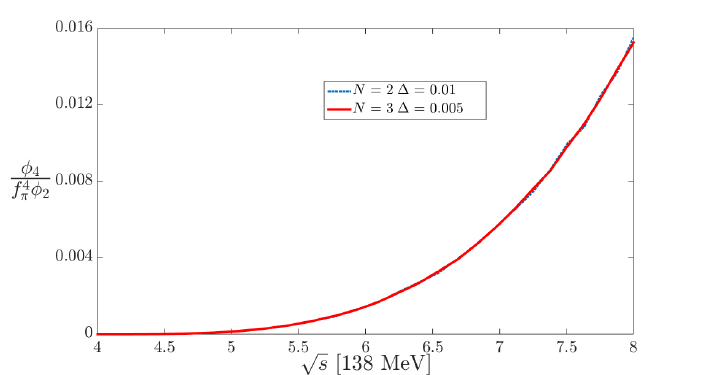
Figure 3: Numerical computation of the four- to two-particle phase-space ratio from (cid:112) (cid:112) s = 4 m π up to s = 1.1 GeV. (The 4-body integral is calculated in threshold successively better approximation by replacing the energy delta function in Eq (44) by a Gaussian of decreasing width ∆ . N is proportional to the number of 20-Gaussian point partitions of each variable’s integration interval. Convergence is excellent and both curves are barely distinguishable.)